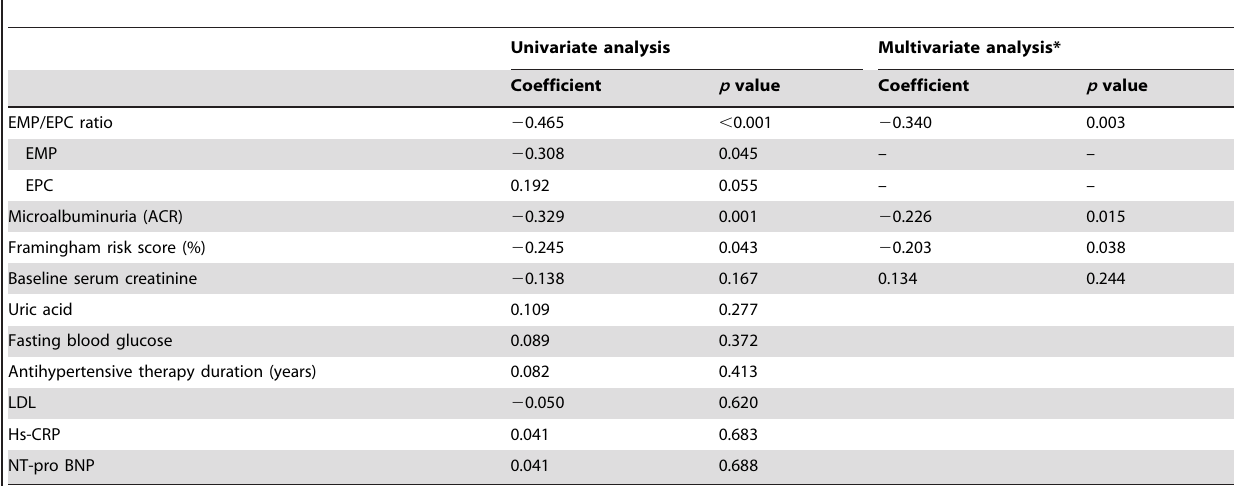
Table 3. Univariable and Multivariable Associations with Annual Change in eGFR Calculated by CKD-EPI